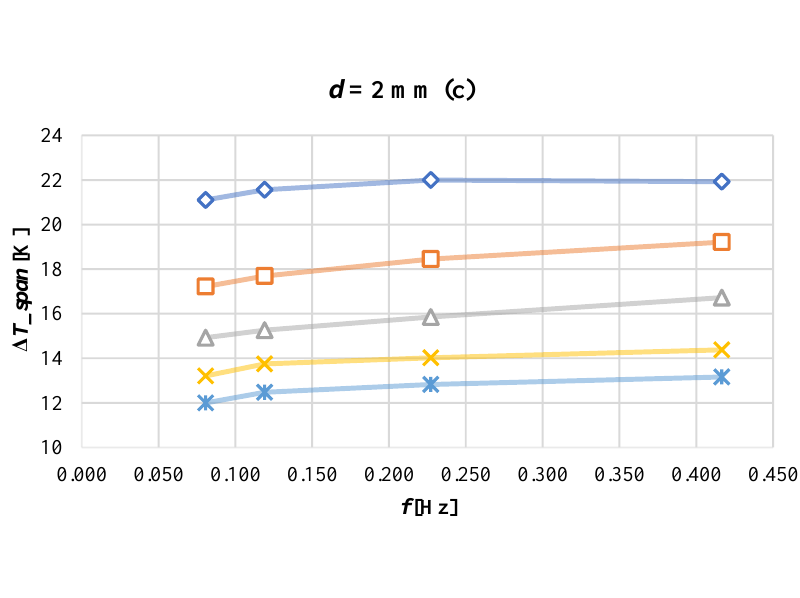
Figure 5. Temperature span as a function of the cycle frequency parametrized for air velocity when the distance between two wires is: ( a ) 0.5 mm; ( b ) 1.0 mm; ( c ) 2.0 mm.